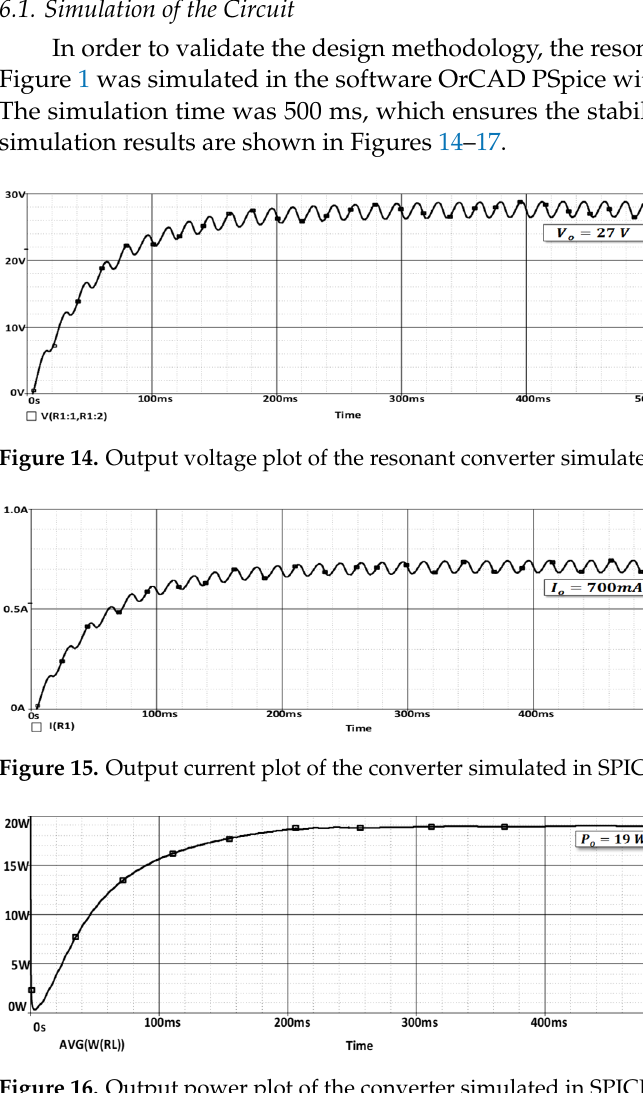
Figure 16. Output power plot of the converter simulated in SPICE.